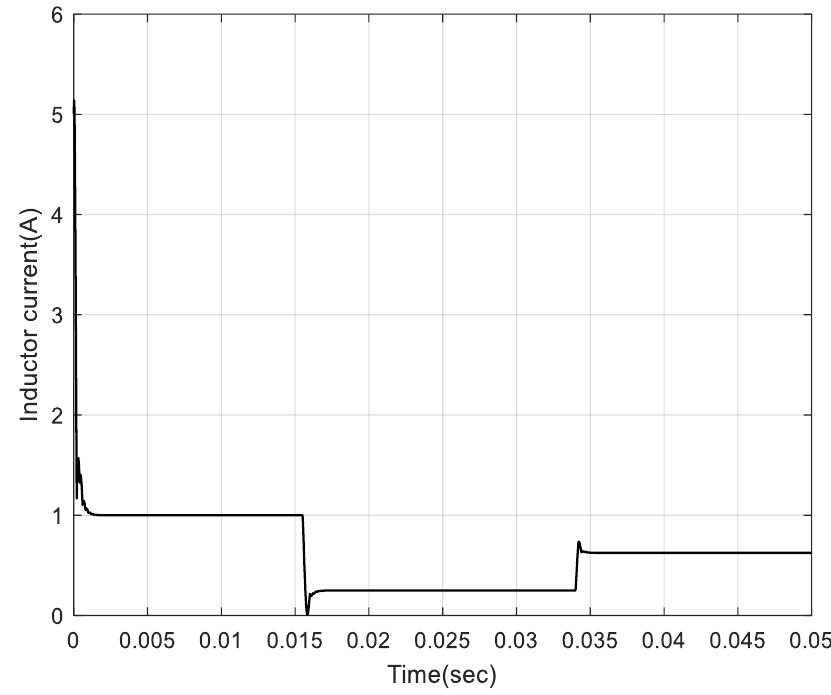
Figure 4. Inductance current responses where the load is